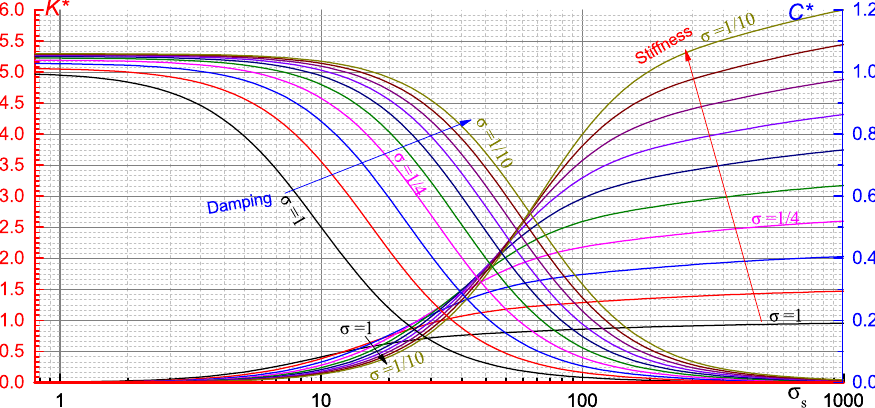
Figure 12. Dynamic coefficients of the 1D parallel slider with supply pressure.